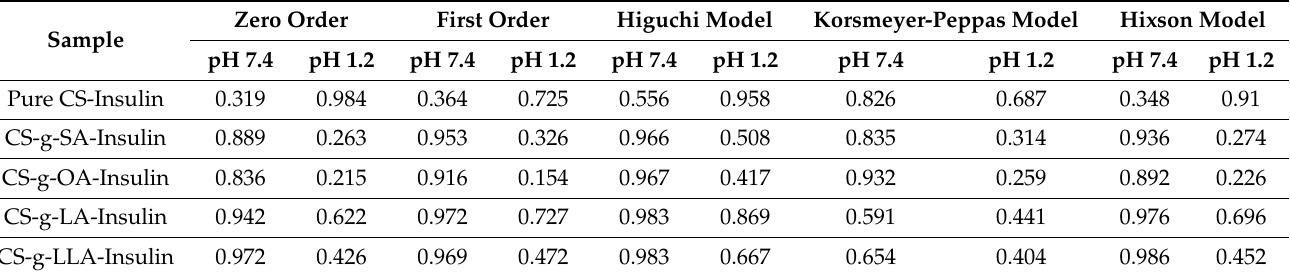
Figure 7. Comparison of R 2 values for the insulin release from various CS-based carriers: ( a ) zero order for pure CS at pH 1.2; Higuchi model of ( b ) CS-g-SA, ( c ) CS-g-OA, ( d ) CS-g-LA, ( e ) CS-g-LLA; and Hixson model for ( f ) CS-g-LLA at pH 7.4. Table 3. Comparison of correlation coefficient (R 2 ) values among the five different pharmacokinetic models for the samples at two different pHs of 7.4 and